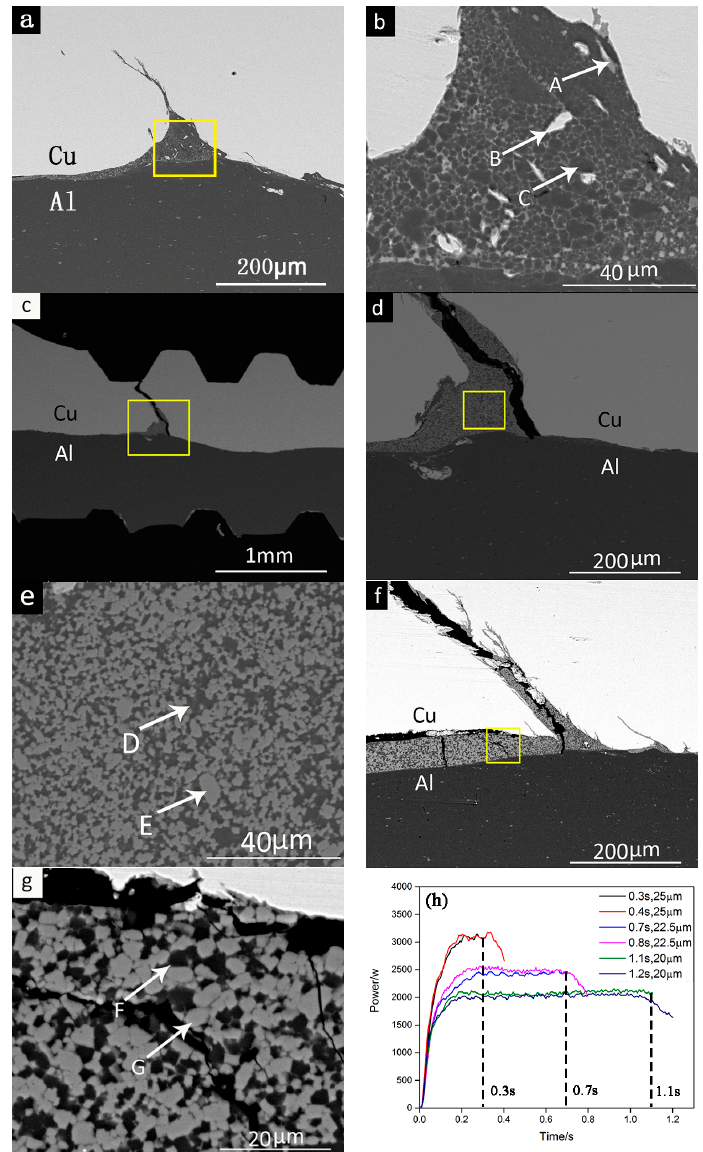
Figure 8. SEM images obtained at the edge of the nugget, ( a ) at the welding time of 1.1 s for the amplitude of 20 μ m, ( c ) at 0.8 s for 22.5 μ m, and ( f ) at 0.4 s for 25 μ m. ( b ) Magnified view of the image in the rectangular frame in ( a ); ( d ) Magnified view of the image in the rectangular frame in ( c ); ( e ) Further magnification of the image in the rectangular frame in ( d ); ( g ) Magnified view of the image in the rectangular frame in ( f ). ( h ) Ultrasonic power output curves at various